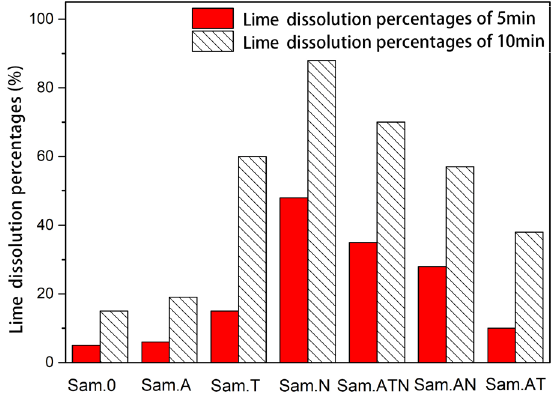
Figure 5. Dissolution percentages of lime in slag after 5 and 10 min.